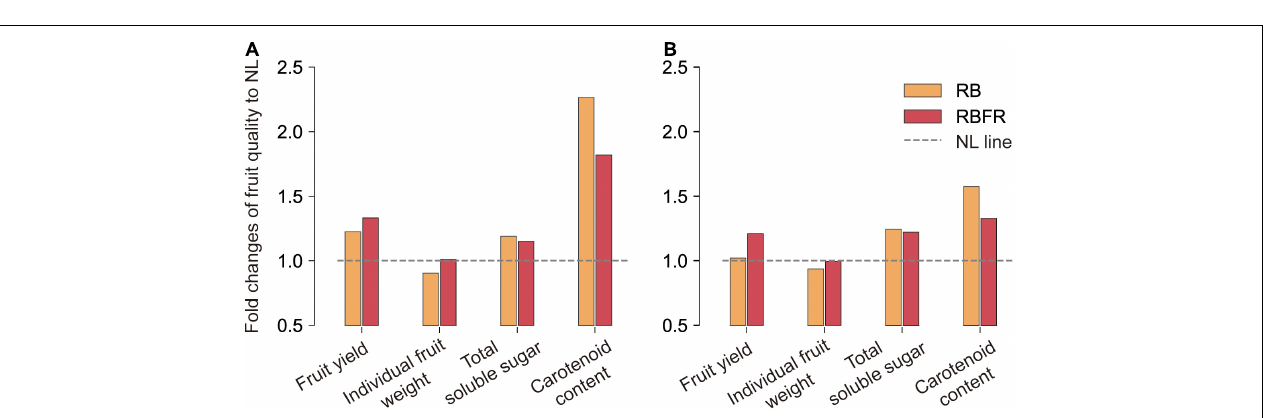
FIGURE 6 | Fold changes in fruit qualities of red (A) and yellow (B) fruits of sweet peppers to natural light (NL) during overall cultivation period. RB and RBFR mean NL with red + blue LED interlighting and RB with far-red light, respectively. Total soluble sugar and carotenoids content were calculated from data over all sampling periods (Referred to Figures 3 , 4